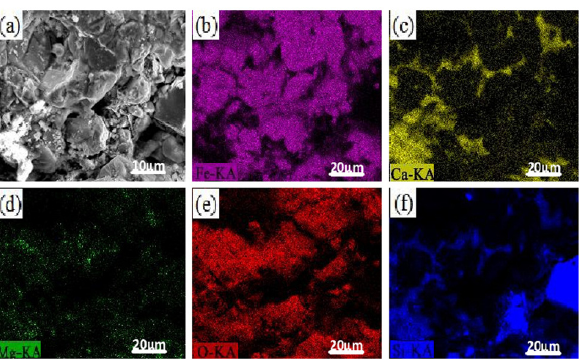
Figure 9: Distribution of the main elements of briquette specimens before reduction at basicity of 0.8. ( a ) SEM - EDS image of briquette, ( b ) Fe - KA, ( c ) Ca - KA, ( d ) Mg - KA, ( e ) O - KA, and ( f ) Si - KA.